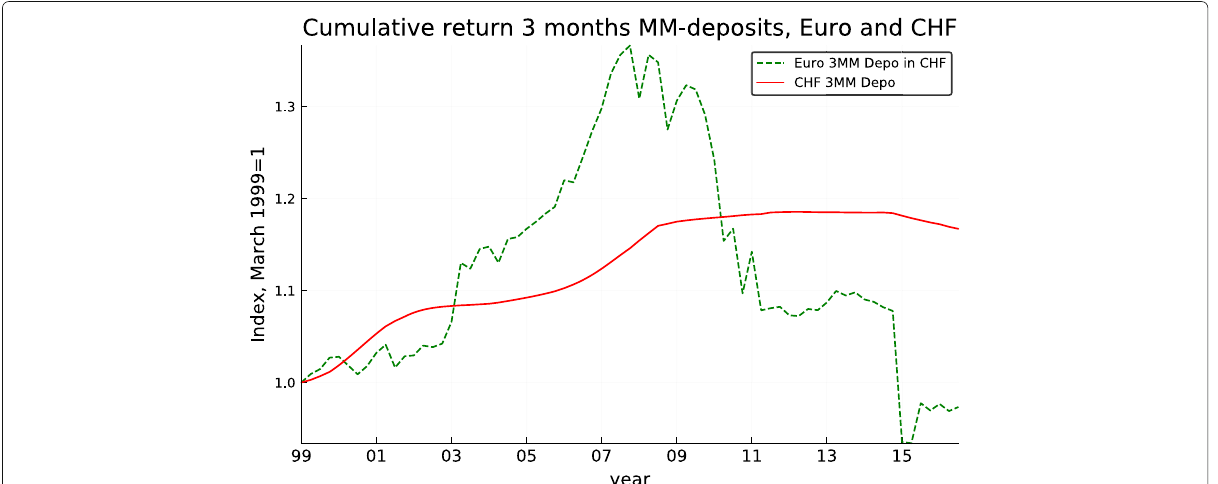
Fig. 4 Cumulative performance of the euro and CHF portfolios since the advent of the euro